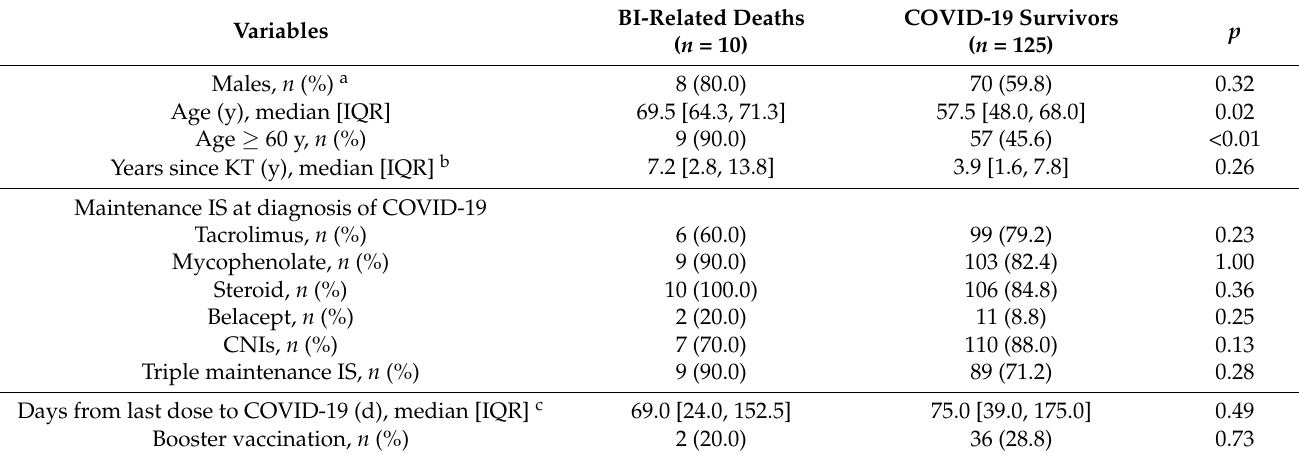
Table 4. Comparison between COVID-19 breakthrough infection-related deaths and